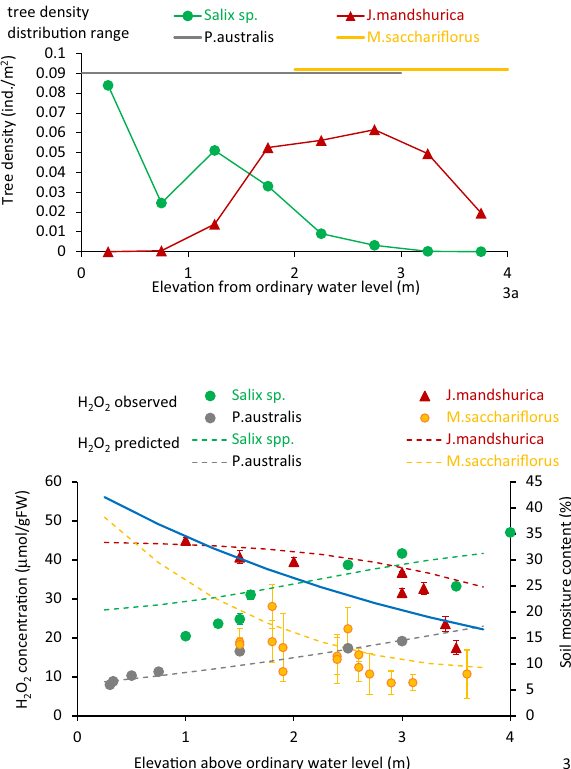
Figure 3. ( a ) Tree density and herb colonies at different elevations at the Hii River site of entire observe area. ( b ) Soil moisture and H 2 O 2 concentration of samples and simulated results from Eq. (3) to (6) distribution are also shown. Vertical bars in ( b ) are standard